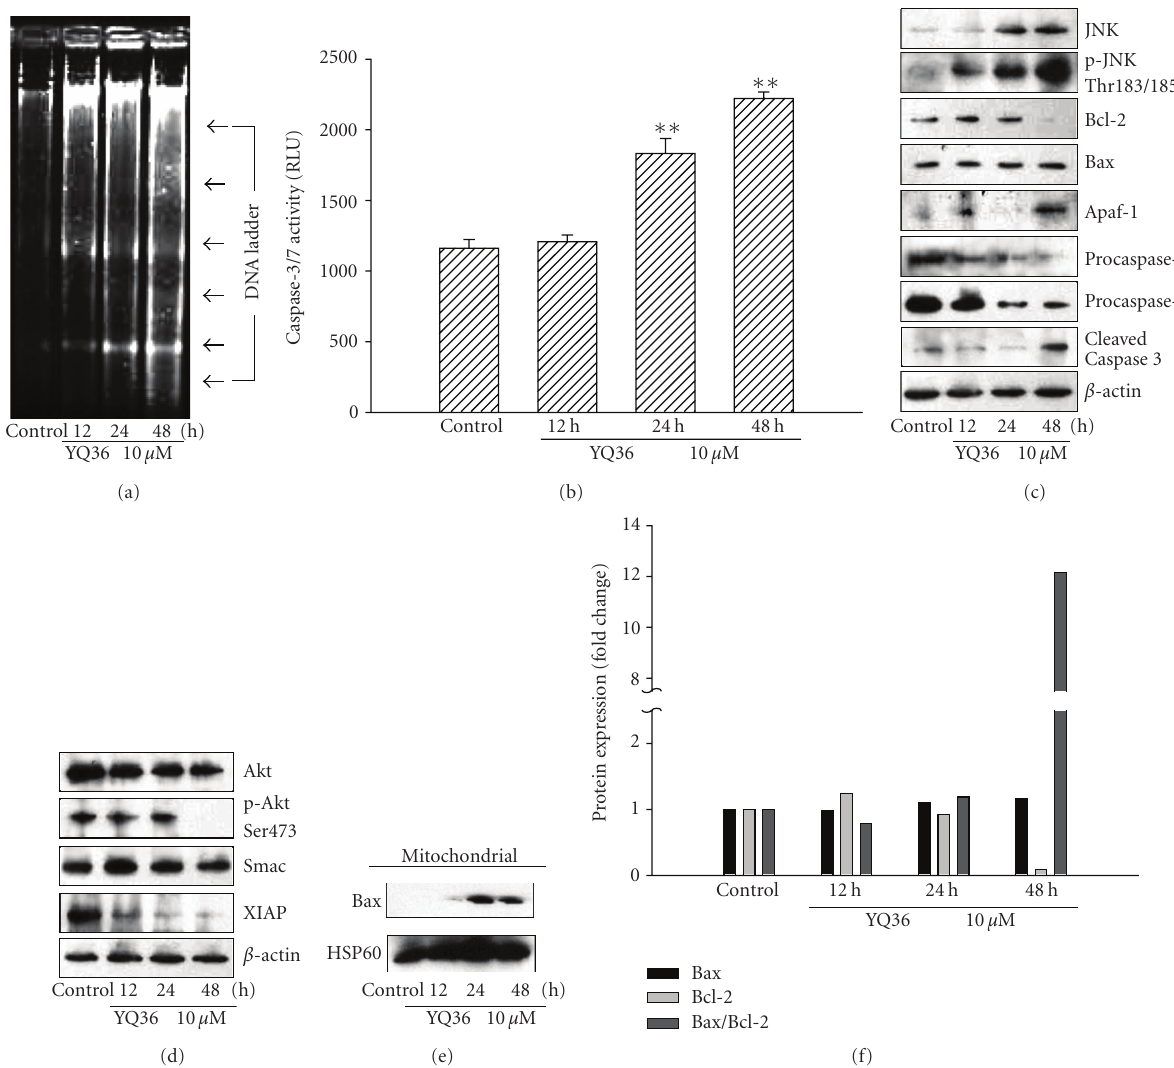
Figure 4: YQ36 caused apoptosis in KB/VCR cells in vitro. (a) YQ36 induced a characteristic fragmentation of DNA in KB/VCR cells (10 μ M, 6–24 hours). (b) The result of measuring caspase-3/7 activity indicated YQ36 induced KB/VCR cells apoptosis in time-dependent manner. The error bars represent standard deviation and ∗∗ represent P < . 01 versus control. (c) Caspase activation and mitochondrial pathway involved in YQ36-induced apoptosis. Cells were treated with YQ36 (10 μ M) for 6, 12, and 24 hours, and whole-cell lysates were collected and immunoblotted with indicated antibodies. (d) The expressions of antiapoptotic proteins were decreased in KB/VCR cells (10 μ M YQ36, 6–24 hours). (e) The protein expression of Bax in mitochondrial fraction after treated with YQ36 (10 μ M) for 6, 12, and 24 hours, and the HSP60 was used as a housekeeper for mitochondrial fraction. (f) Densitometric analysis of expression of Bcl-2 and Bax relative to the control.